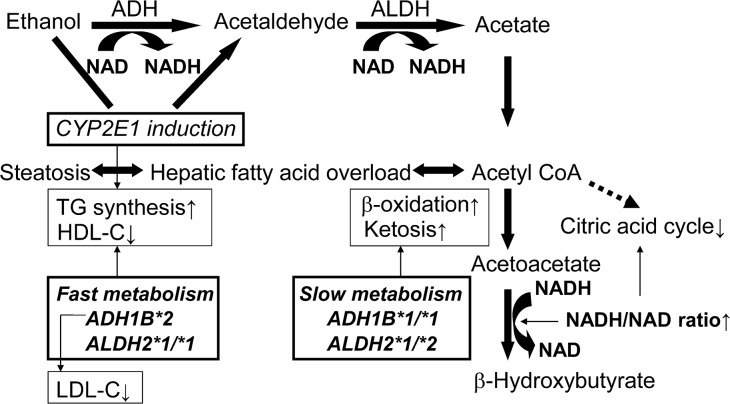
Interactions between the metabolism of ethanol and lipids and alcohol-metabolizing enzymes in alcoholics.ADH, alcohol dehydrogenase; ALDH, aldehyde dehydrogenase; CYP2E1, cytochrome p4502E1; HDL-C, high-density lipoprotein cholesterol; LDL-C, low-density lipoprotein cholesterol; TG, triglyceride. Thin arrows indicate a promoting effect.